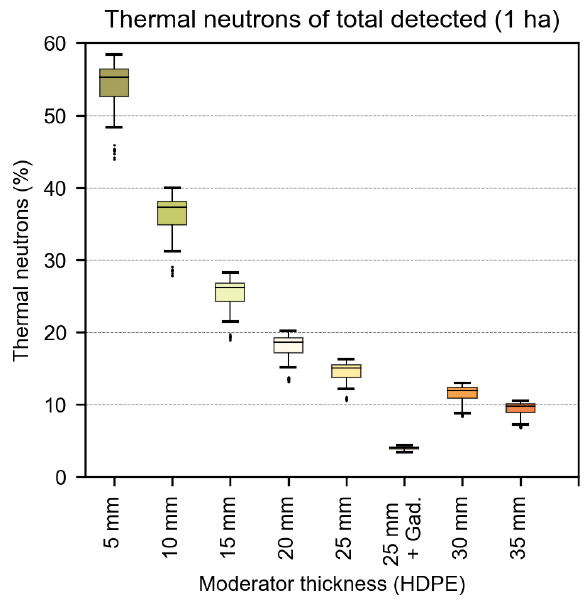
Figure B1. Boxplot of the percentage of detected thermal neutrons over the total number of neutrons that are detected with different moderator types for the 1ha scenario (each boxplot shows the re- sults of 100